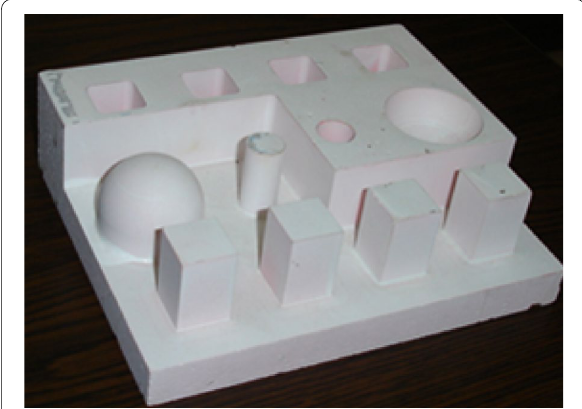
Figure 8 Picture of the model with specially fabricated complex